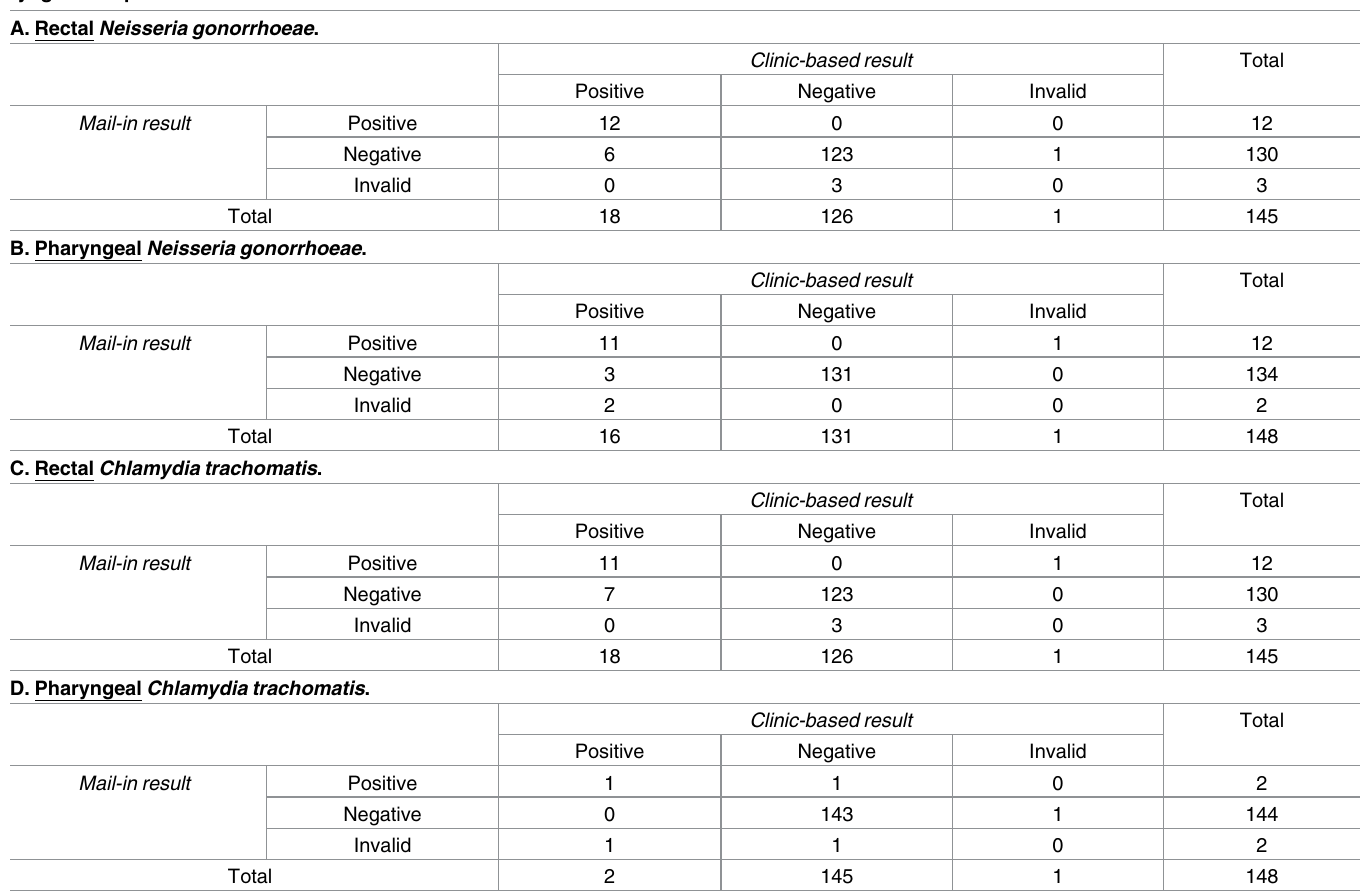
Table 1. Comparison of clinic-based specimen collection and mail-in specimen collection on Xpert for detection of CT and NG in rectal and pha- ryngeal